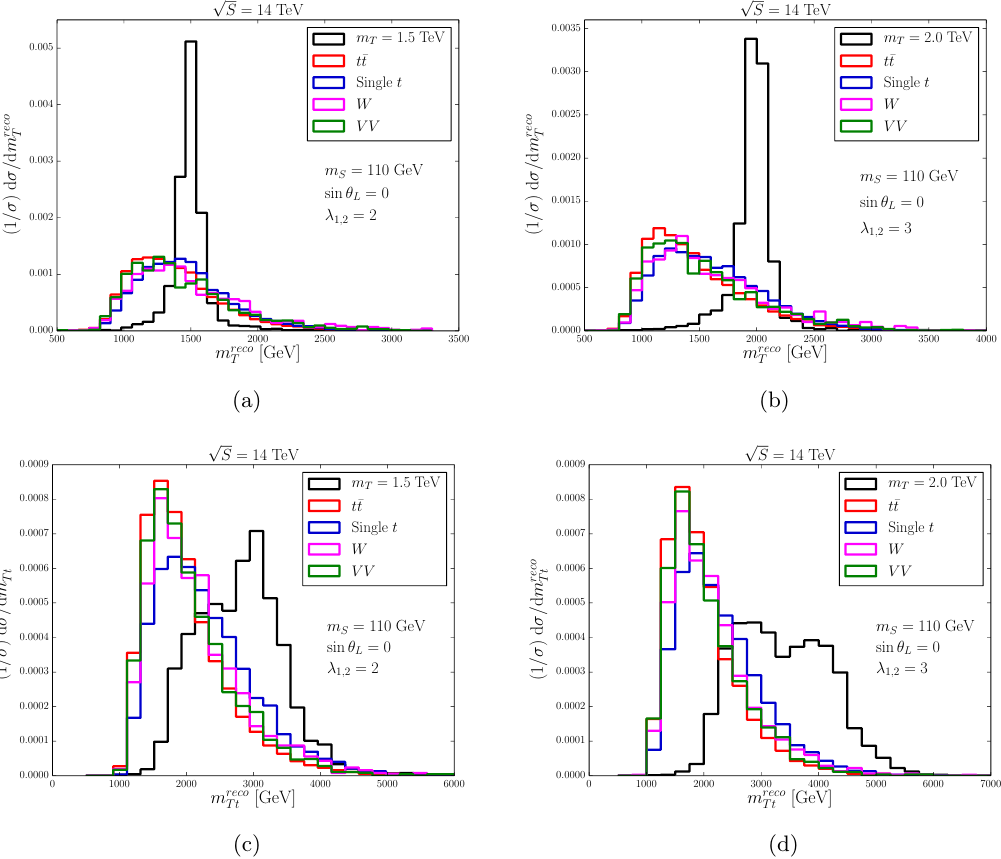
Figure 18 . The reconstructed T invariant mass m reco and (b) 2 TeV. The reconstructed system invariant mass m reco 1.5 TeV and (d) 2 TeV. All plots are generated based on events after showering, hadronization, and detector e(cid:11)ects. The other model parameters are set to m S = 110 GeV and sin (cid:18) L = 0.